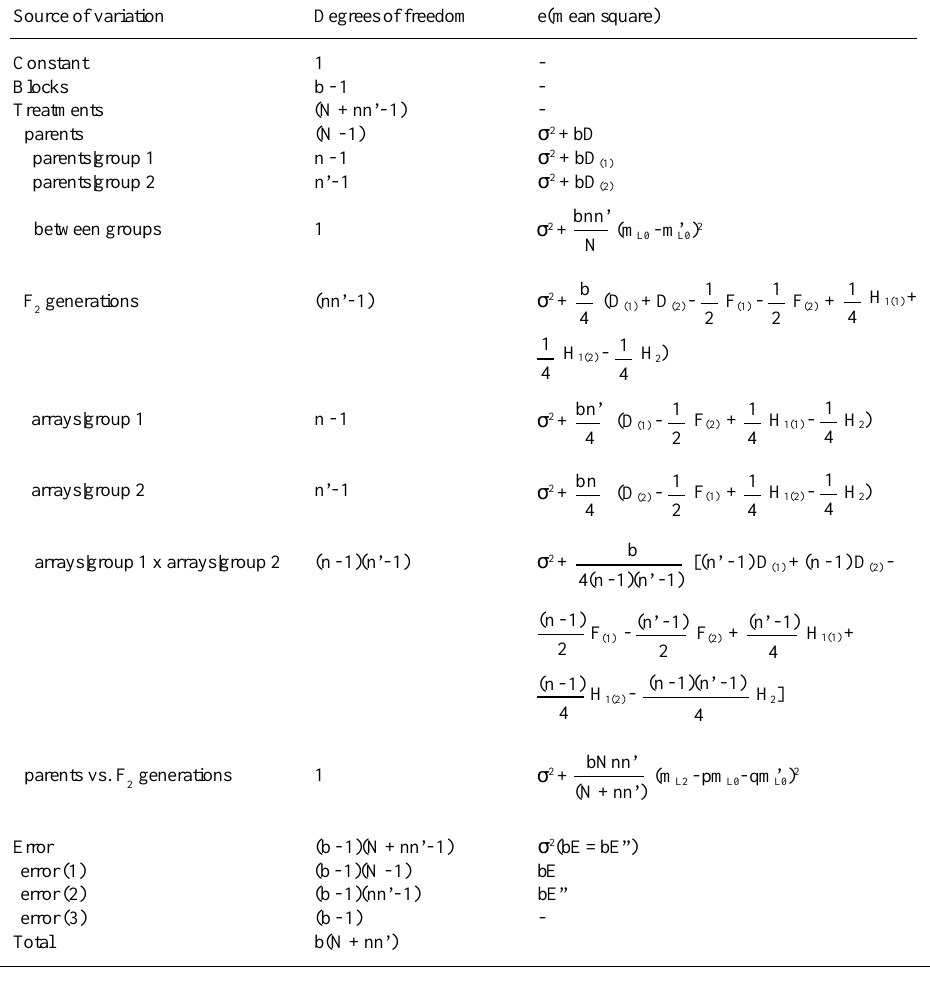
Table II - Analysis of variance of partial diallel involving the parents and their F generations arranged in a randomized complete block